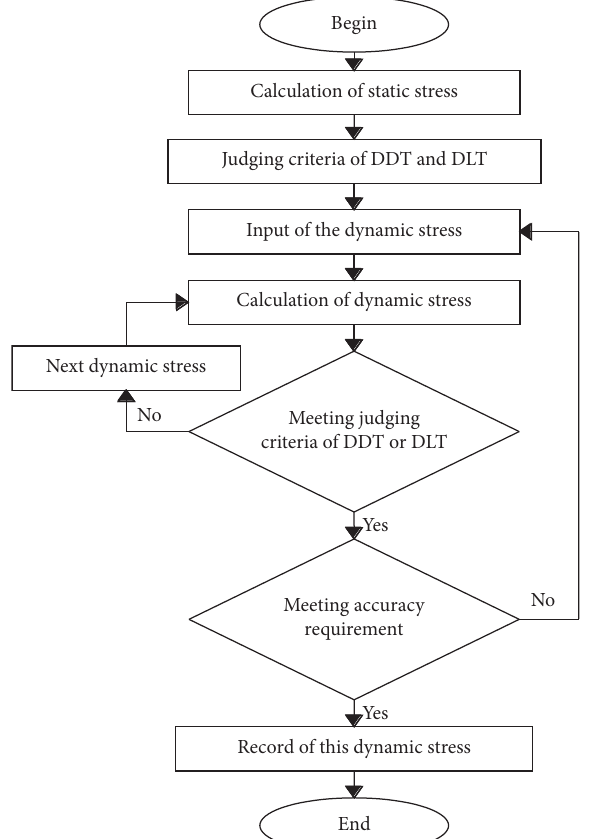
Figure 6: Dynamic threshold algorithm. The main process includes four sections. In the first section, the calculation of static stress is carried out using the numerical simulation model until the stress keeps balance. In the second section, the judging criteria of DDT and DLT are determined using the method of zero growth DDI of plastic failure zone and the engineering-permitted limitation dis- placement method. In the third section, the calculation of servo stress wave is carried out using the numerical simulation model until the stress wave meets the judging criteria and the accuracy requirement. Finally, DDT and DLT are